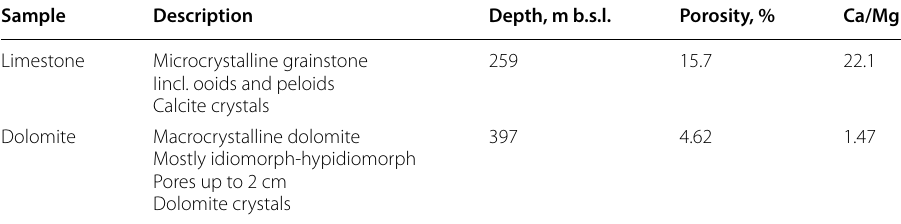
Table 2 Matrix description. Bartels et al. (2015) Sample